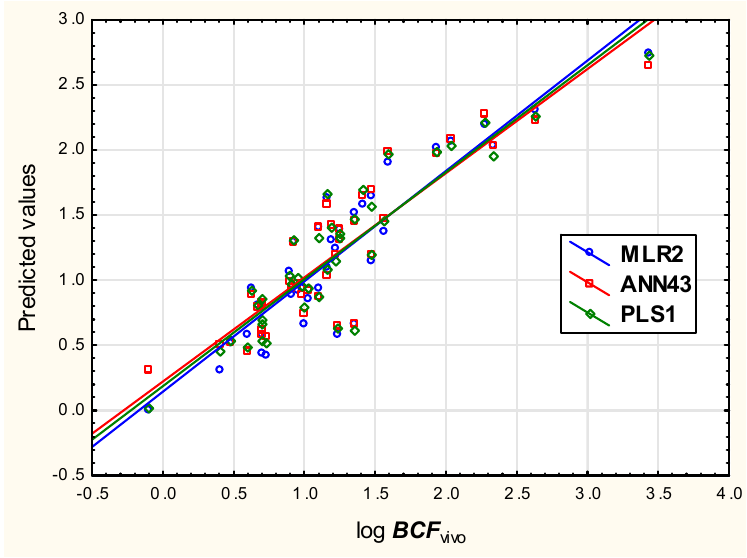
Figure 9. Predicted vs. experimental log BCF values for models MLR2, PLS1 and ANN43 .